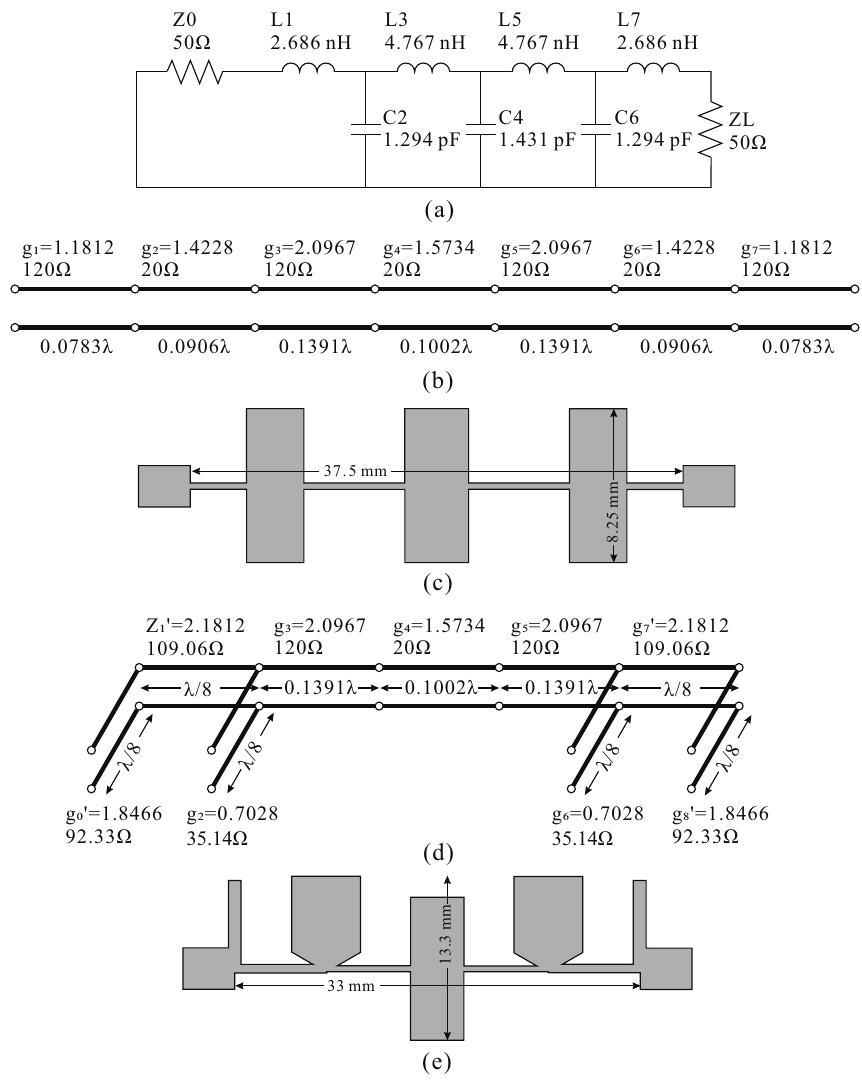
Figure 2. A seventh-order Chebyshev low-pass filter (LPF). ( a ) An equivalent circuit of the lumped element model, ( b ) a transmission-line model of LPF step-impedance, ( c ) an optimized microstrip line model of LPF step-impedance, ( d ) a transmission-line model of the proposed LPF, and ( e ) an optimized microstrip line model of the proposed